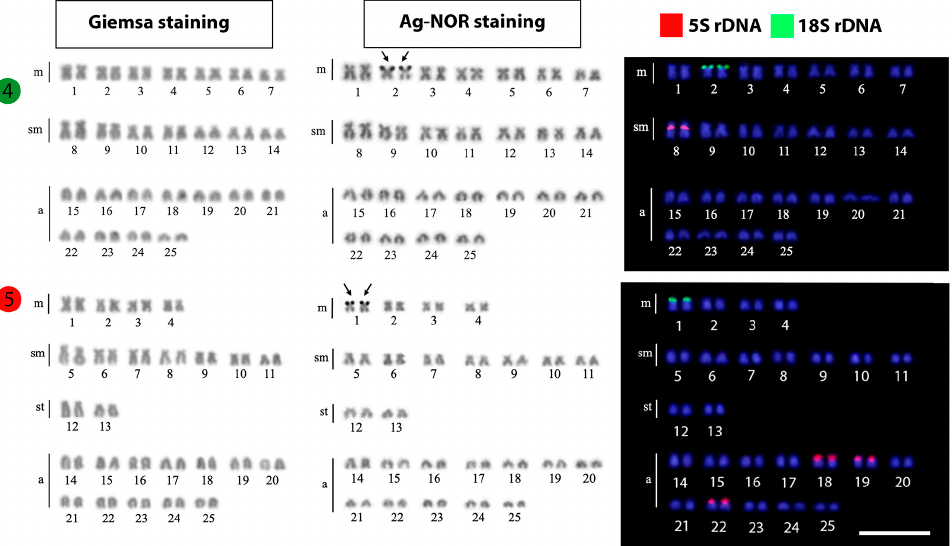
Figure 3. Karyotypes of ‘poropuntiinae’ species arranged from Giemsa-stained, Ag-NOR banding chromosomes and chromosomes (arrows) after FISH with 5S (red) and 18S (green) rDNA probes. 4 = H. wetmorei ; 5 = M. chilopterus . Chromosomes were counterstained with DAPI (blue). Scale bar = 5 µ